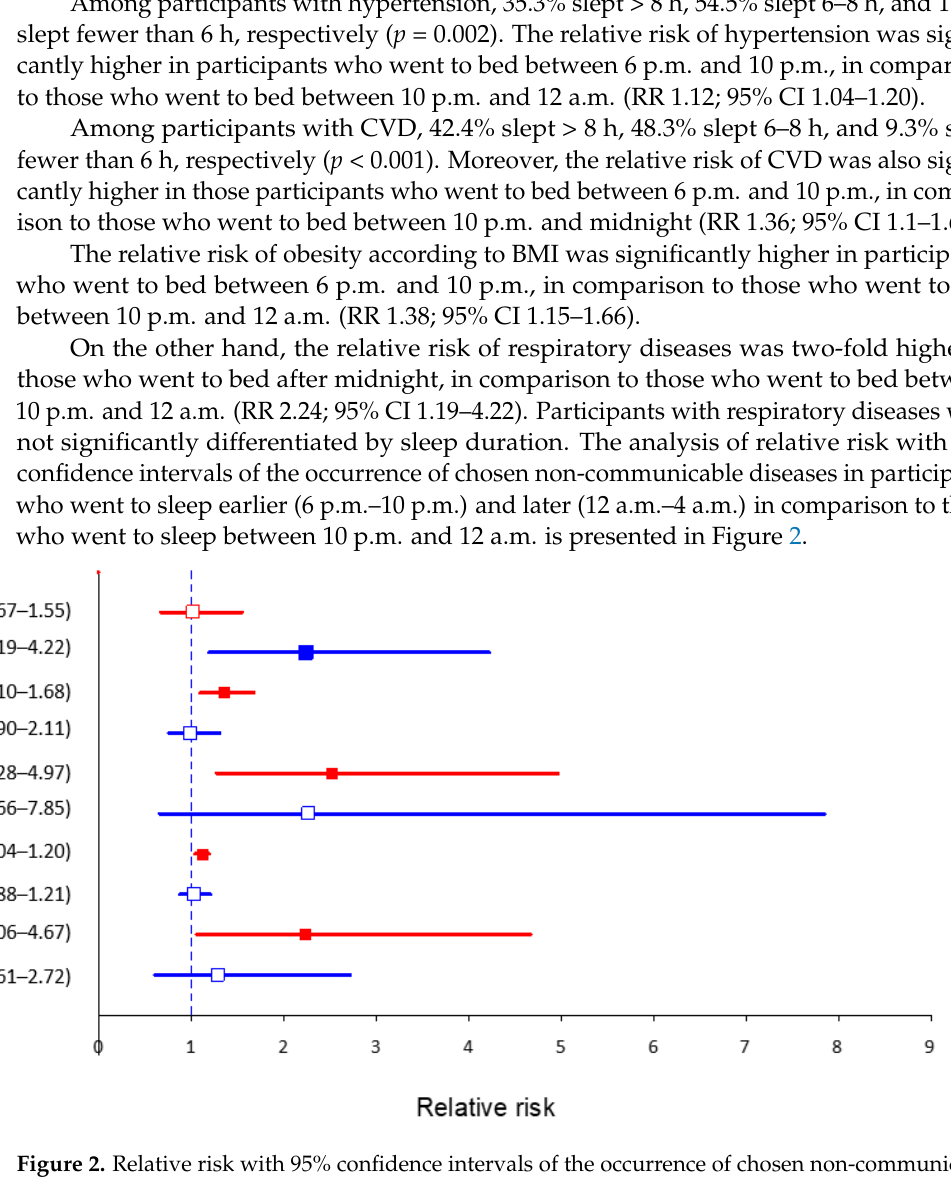
Figure 2. Relative risk with 95% confidence intervals of the occurrence of chosen non-communicable diseases in participants who went to sleep earlier (6 p.m.–10 p.m., indicated by the red color) and later (12 a.m.–4 a.m., indicated by the blue color) in comparison to those who went to sleep between 10 p.m. and 12 a.m. (reference value).